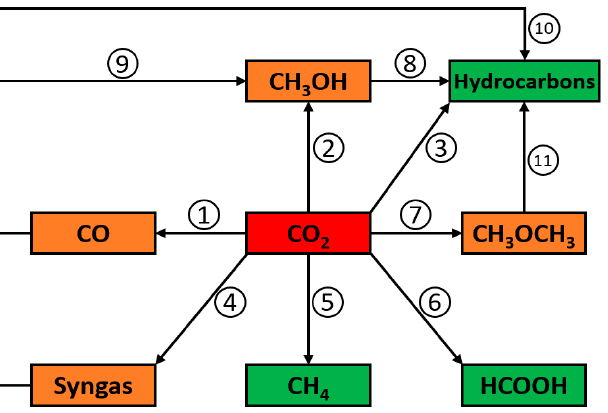
Figure 2. Reaction routes involved in catalytic hydrogenation of CO 2 to value-added chemicals.